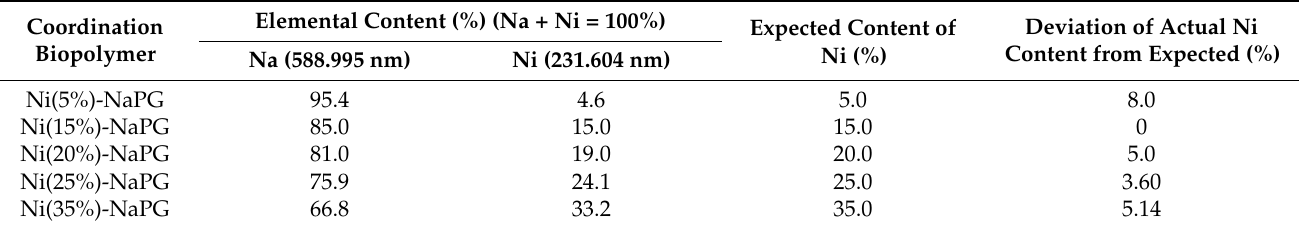
Table 3. The content of Na and Ni in the synthesized Ni(n%)-NaPG coordination polymers deter- mined using an AES iCAP 6300 DUO (Varian, Palo Alto, CA, USA) with synchronous inductively coupled